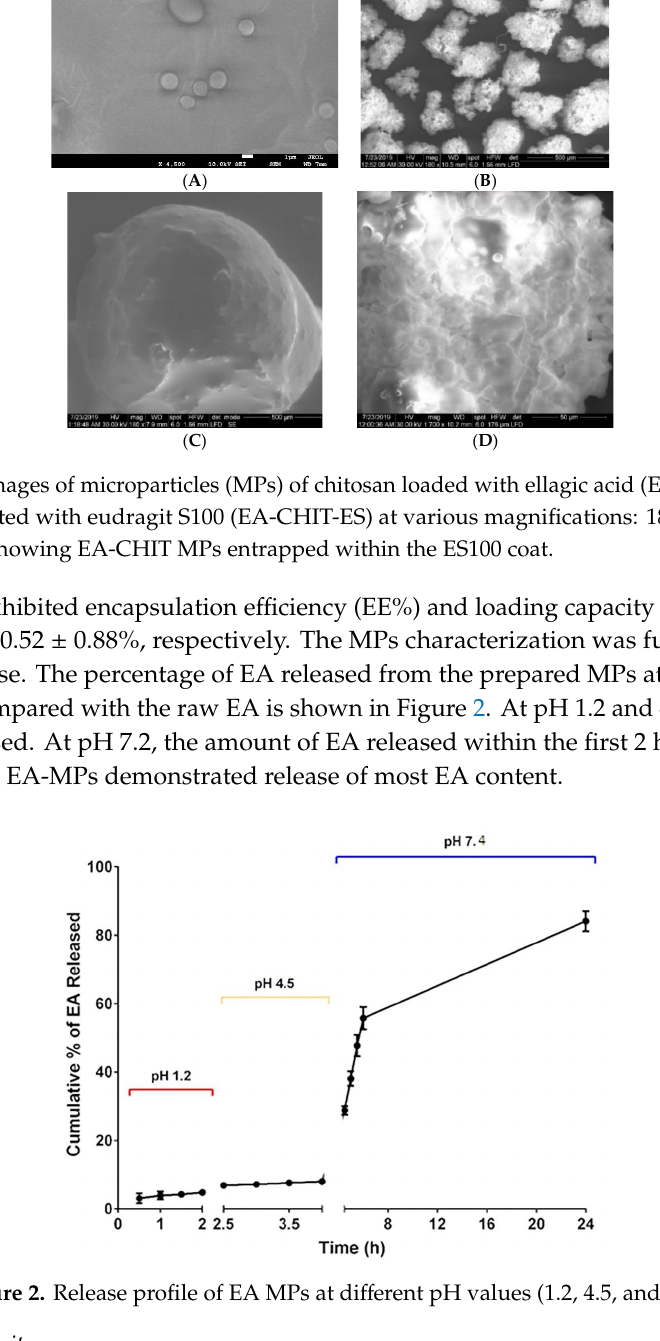
Figure 3. IC 50 of plain MPs, raw EA, and the EA MPs in( A ) the HCT 116 cells and ( B ) EA.hy926 cells. 3.3. Analysis of Progression of the Cell Cycle